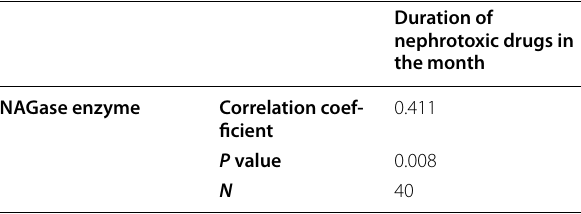
P < 0.05 is considered statistically significant